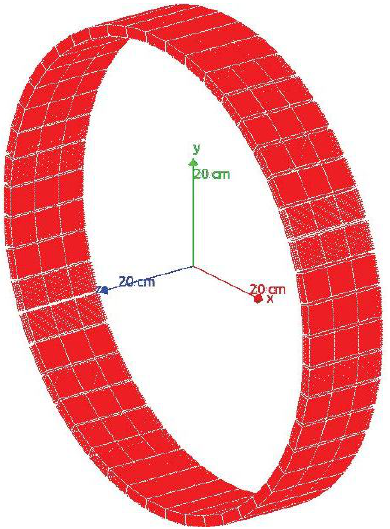
Figure 3. PET system object of study.